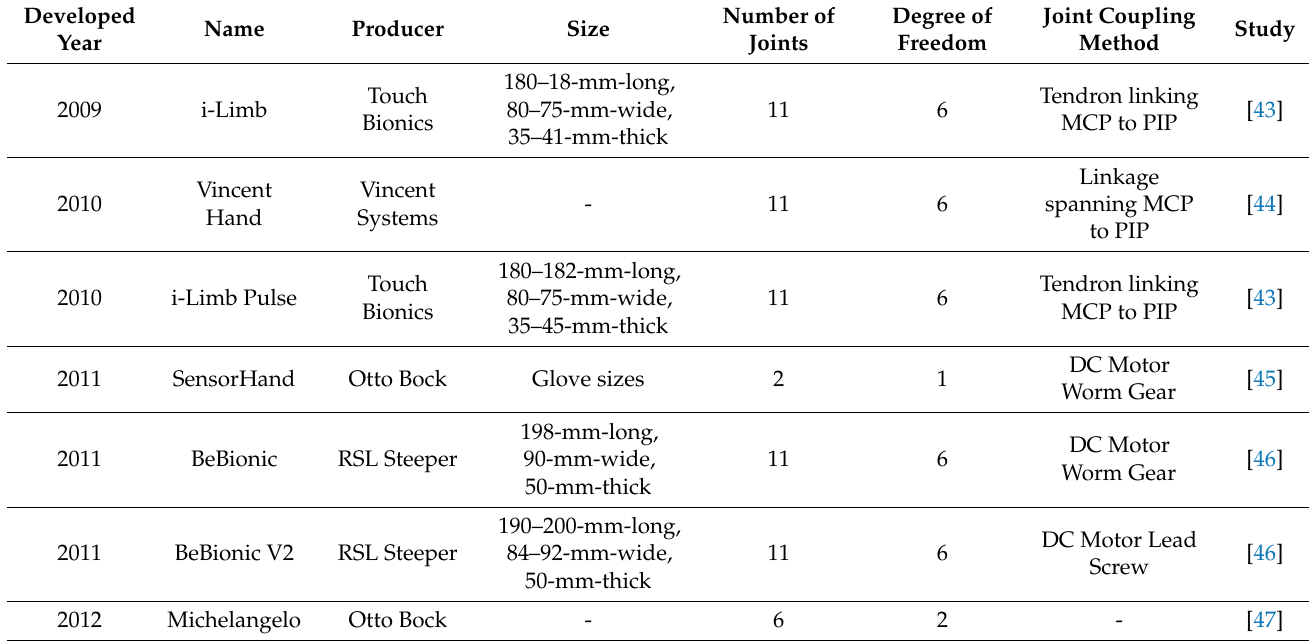
Table 2. Various myoelectric hand/finger prostheses details.